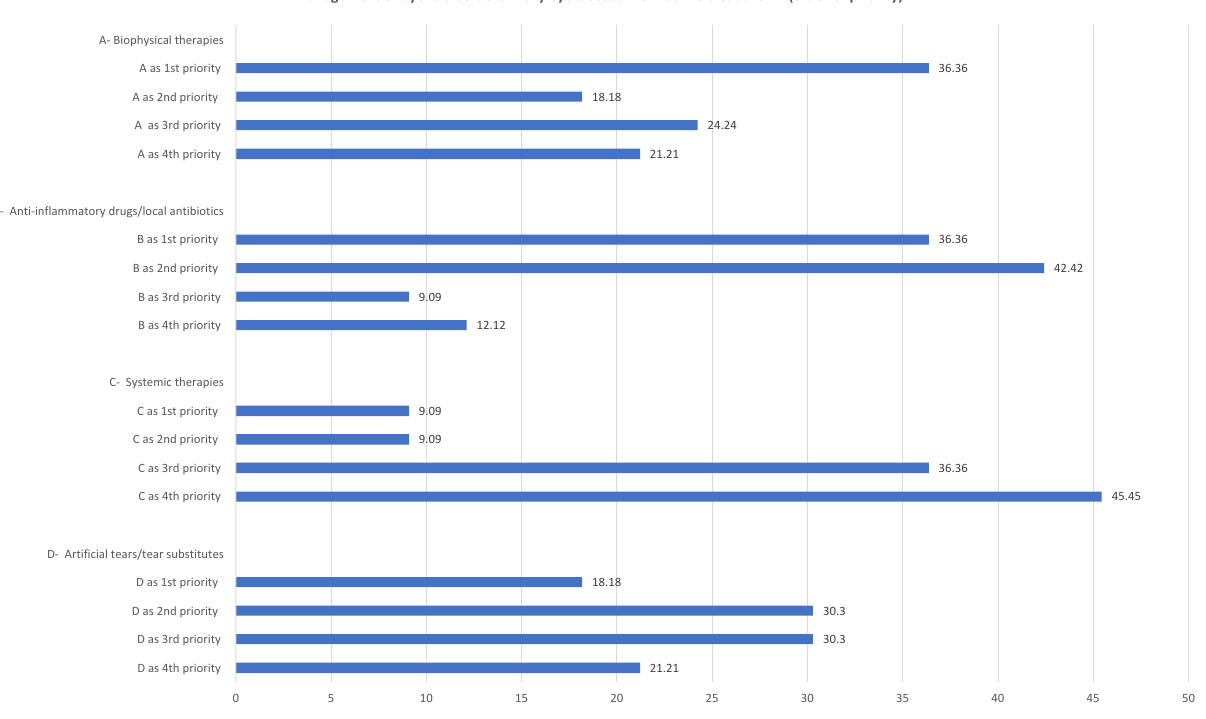
Figure 2. The ranking of the priorities attributed to the two statements related to the management of eyelid disorder in dry eye